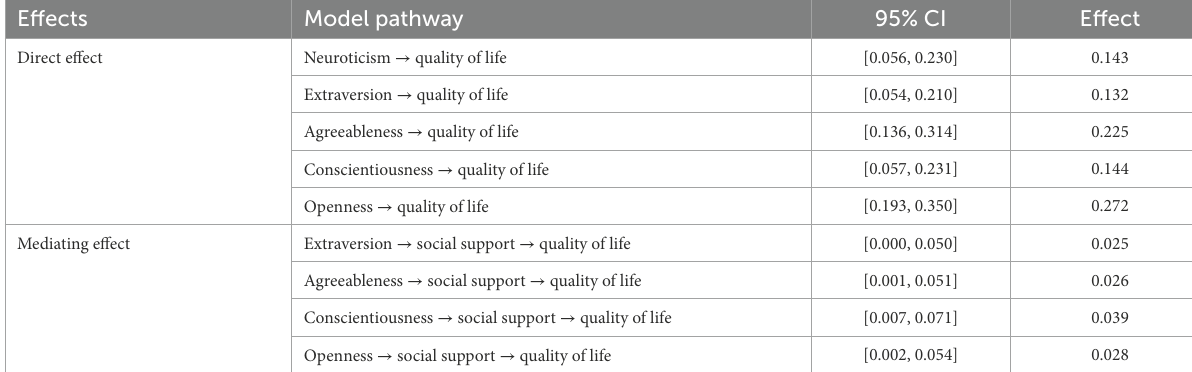
TABLE 3 Bootstrap results for each path coefficient of the hypothetical